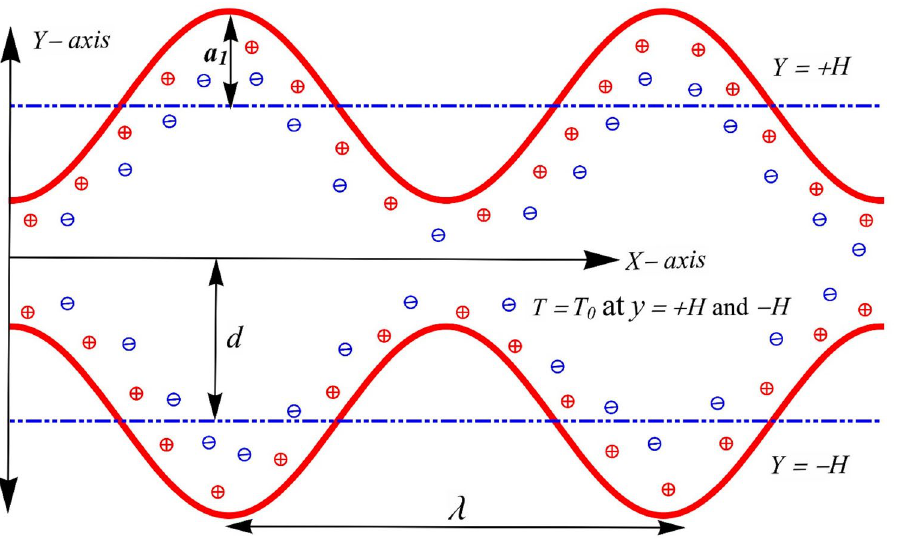
Figure 1. Geometry of the considered